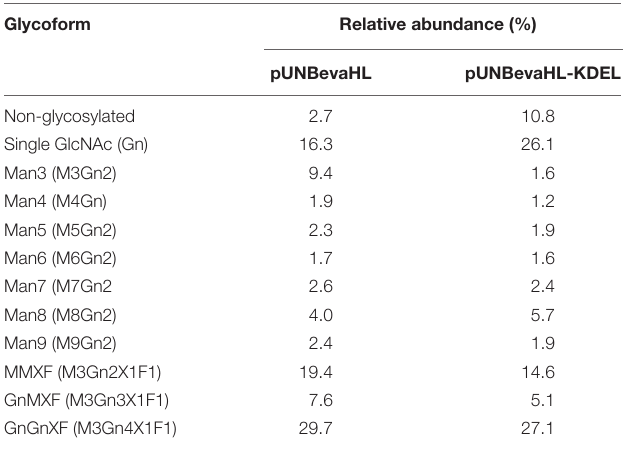
TABLE 2 | Mass spectrometric analysis of glycopeptides from purified mAb after tryptic digestion.